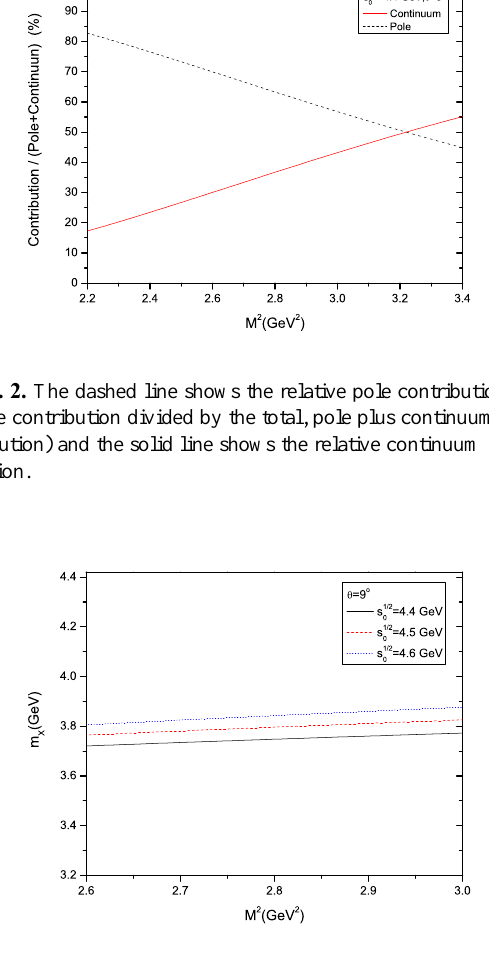
Fig. 3. The X meson mass as a function of the sum rule parameter ( M 2 ) in the stability region for di ff erent values of the continuum = 4 . 4 GeV (solid line), s 1 / 2 = 4 . 5 GeV (dashed threshold: s 1 / 2 0 0 = 4 . 6 GeV (dotted line). line) and s 1 / 2 0